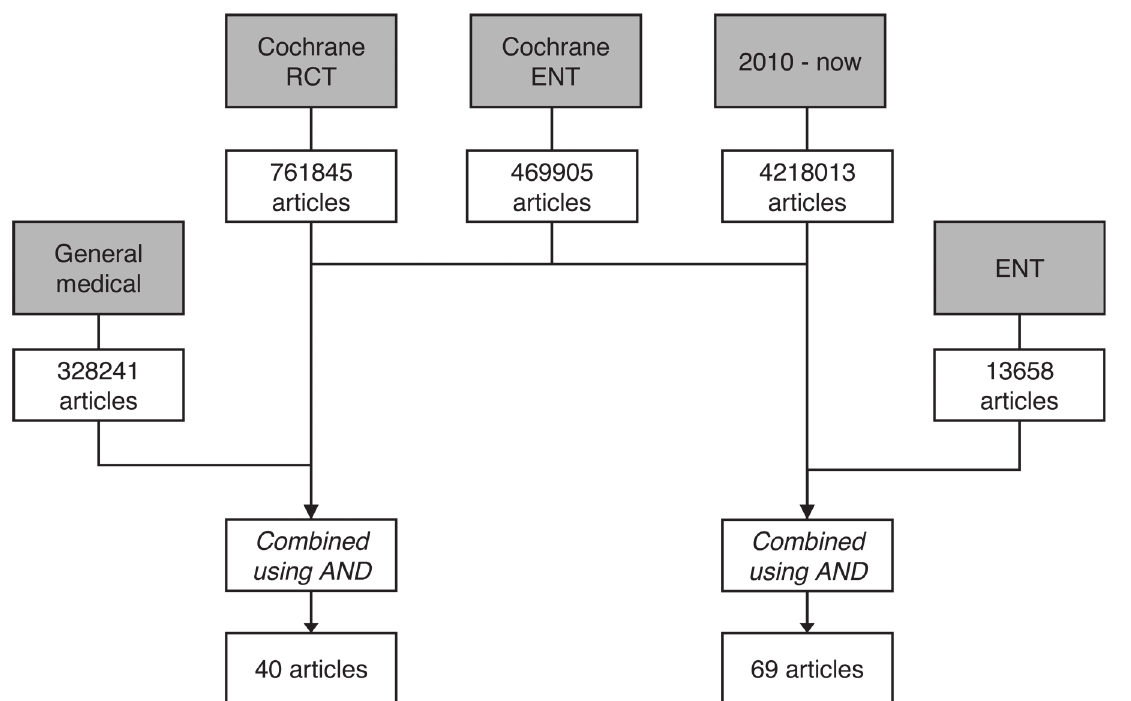
Fig 1. Flowchart of search. Date of search: June 25 th , 2014. For complete search syntaxes: see S1 File.